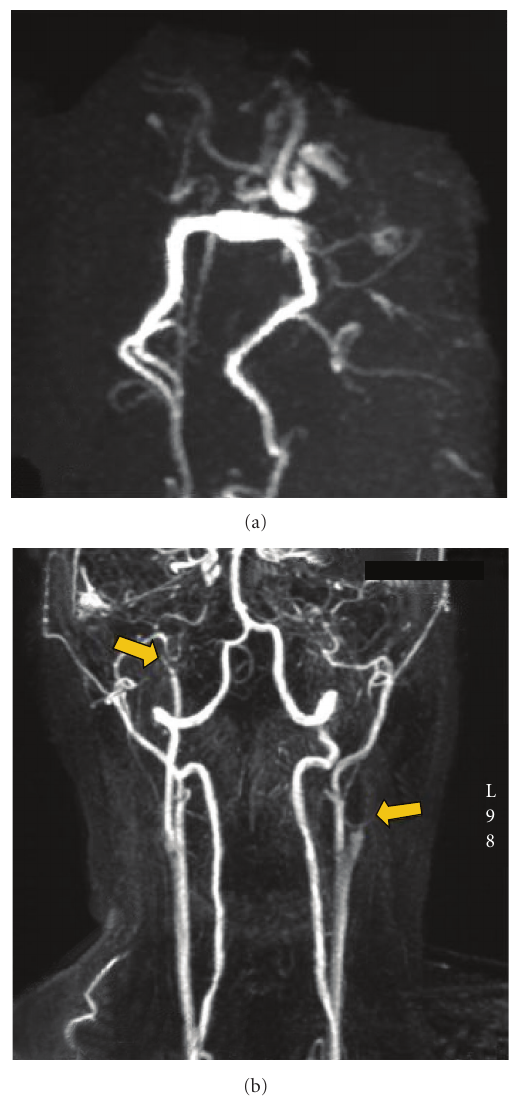
Figure 4: (a) Intracranial MRA of Willis circle: right siphon, right and left MCAs were not visible. Posterior communicating arteries were also not visible, with visible posterior cerebral arteries. (b) Cervical MRA showing proximal left internal carotid artery occlusion and distal right internal carotid artery tight stenosis